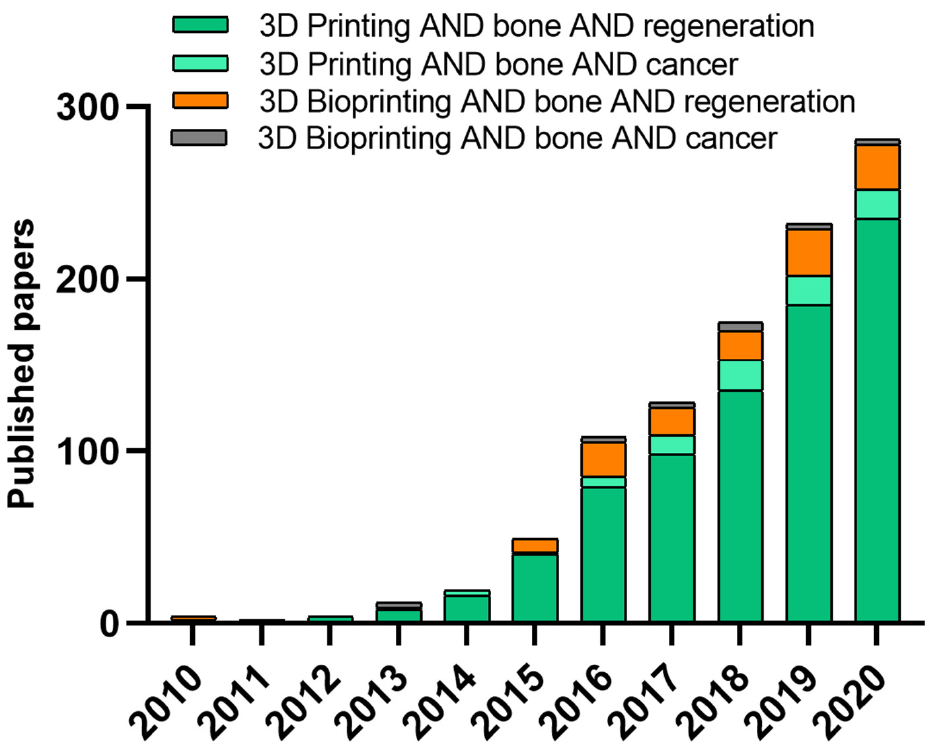
Figure 3. Comparison of uses of 3D printing and 3D bioprinting approaches over time (based on Web of Science, type of document was article, keywords for “3D printing” AND “bone” AND “regeneration”, “3D printing” AND “bone” AND “cancer”, “3D bioprinting” AND “bone” AND “regeneration” and “3D bioprinting” AND “bone” AND “cancer”).